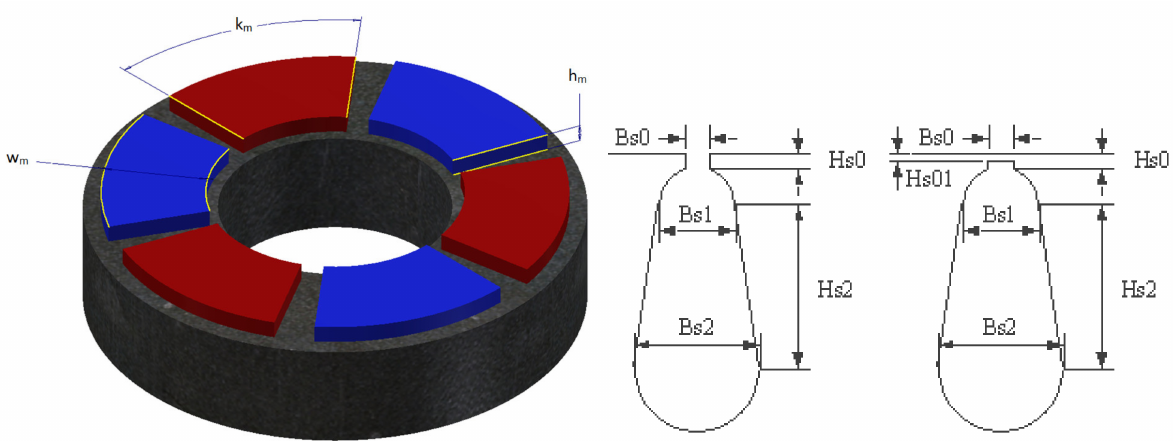
Figure 3. Finding the optimal width ( w m ), active surface area ( k m ), and thickness ( h m ) of permanent magnets on the outer rotor ( left ); finding the optimal dimensions of stator slots ( center ), and the optimal dimensions of the inner rotor closed slots ( right ).